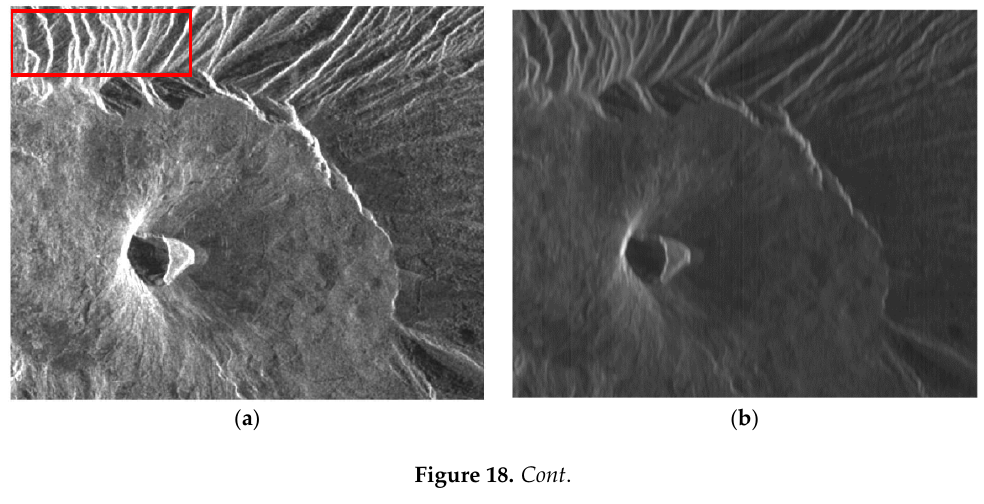
Figure 17. Optical image of Mount Vesuvius taken from Google Earth ® acquired on 29 July 2010: plants cover most of the backslope.